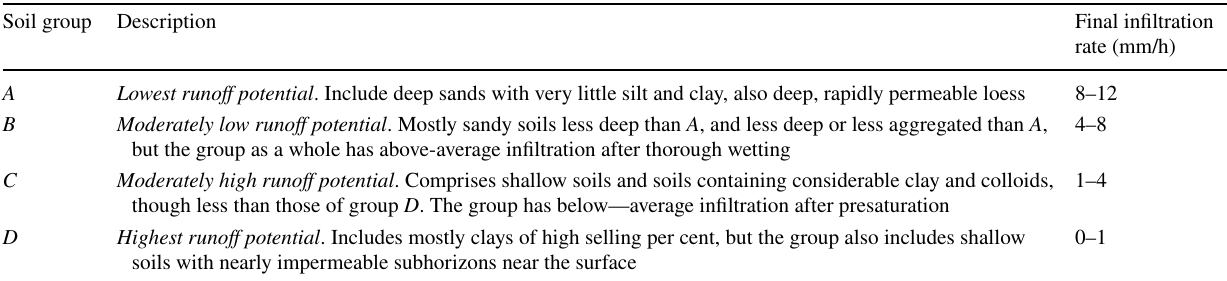
Table 4 SCS hydrological soil group by USDA (1986) Soil group Description